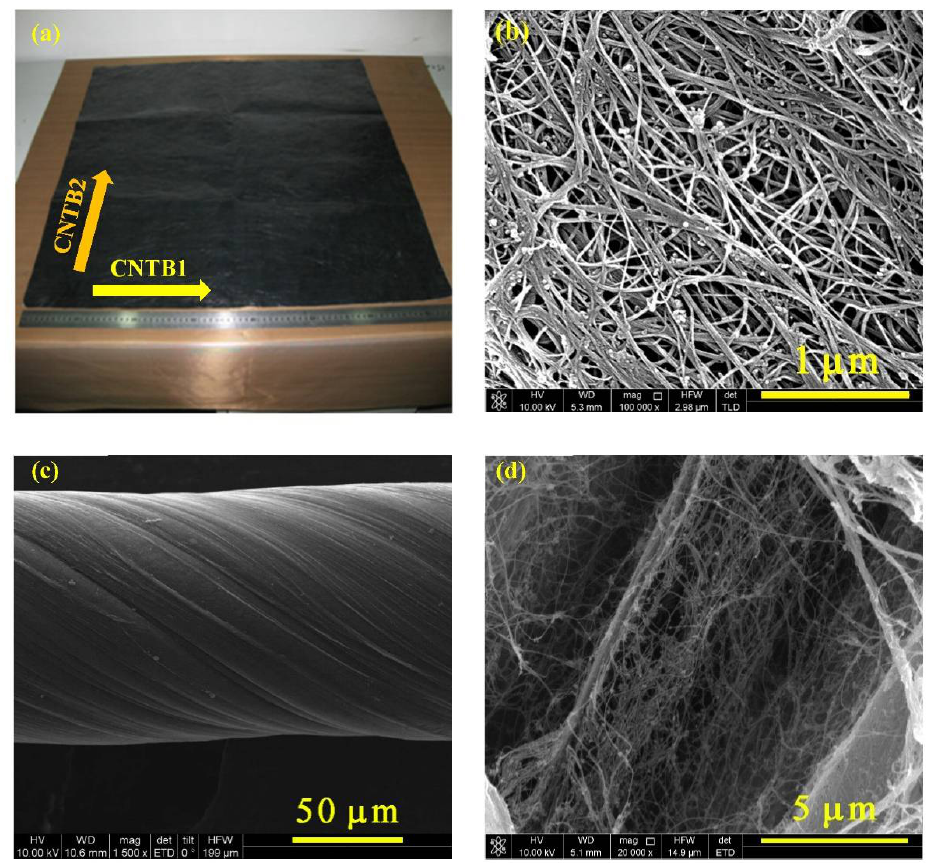
Figure 1. ( a ) The intact carbon nanotube film (CNTB) before the TET experiments. ( b ) The SEM image of the CNTB. The SEM images of CNTF under different magnifications of ( c ) 1500 × and ( d ) 20,000 × . These indicate CNTB and CNTF are made of innumerable carbon nanotube fibers arranged